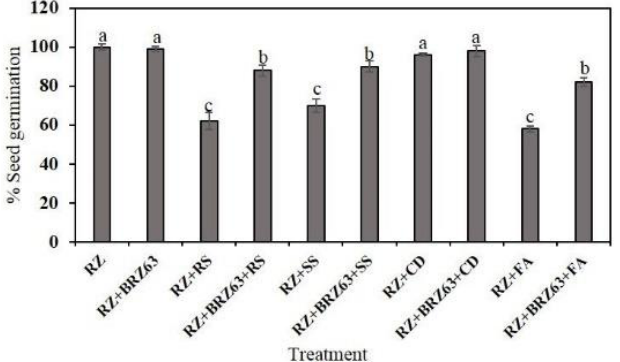
Figure 5. Germination efficiency of oilseed rape seeds after different treatments. The different letters (a–c) above the bar represent significant differences ( p < 0.05) in the germination percentage. The treatments are described in Section 4.8.